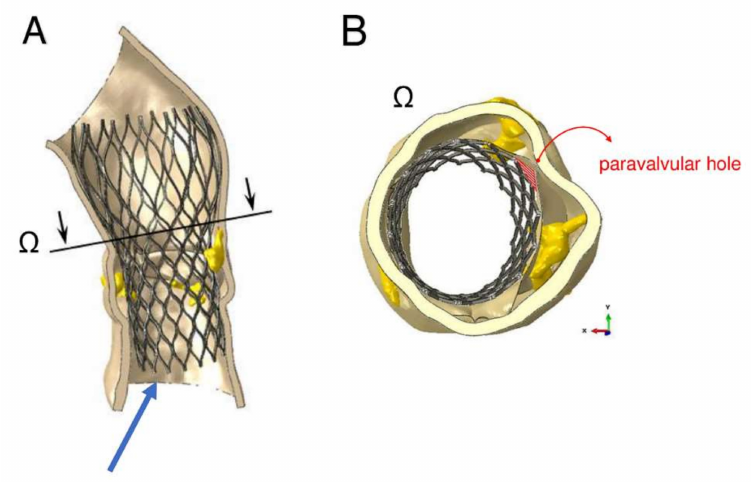
Figure 9. Areas of paravalvular leak can be measured as area of the orifices generated between the inner aortic wall and the device, after its expansion. The amount of blood flow regurgitation could be also quantitatively and indirectly evaluated from the dimension of paravalvular orifice. ( A ) cutting plane Ω correspondent to sino-tubular junction (STJ) of the model with incomplete expansion of the inferior part of the device (blue arrow). ( B ) Mismatch between expanded stent and inner aortic root wall is indicative of the development of paravalvular leakage (PVL) (red